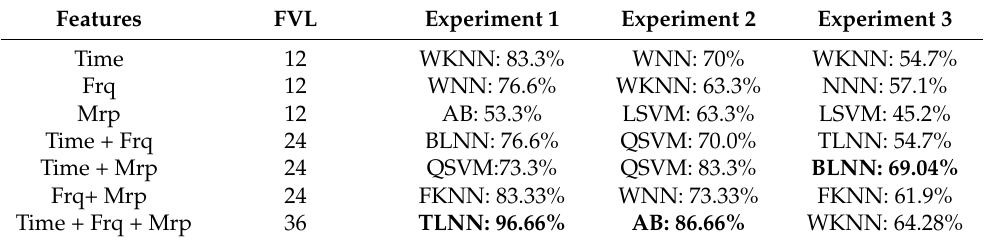
Table 8. Summary of best-performing features and classification methods for all experiments. Experi- ment 1: no pain vs. high pain, Experiment 2: no pain vs. low pain, Experiment 3: no pain vs. low pain vs. high pain. Bold text indicates significant